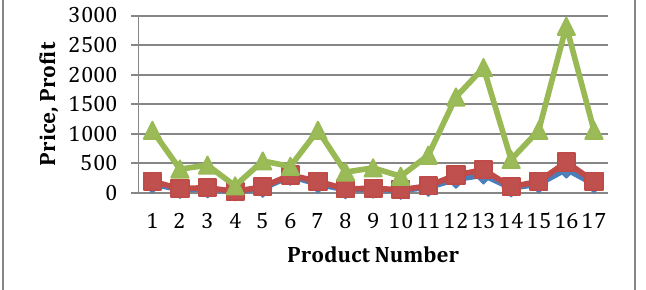
Figure 21: Variation of remanufactured product price, reused product price and remanufactured product profit for different product